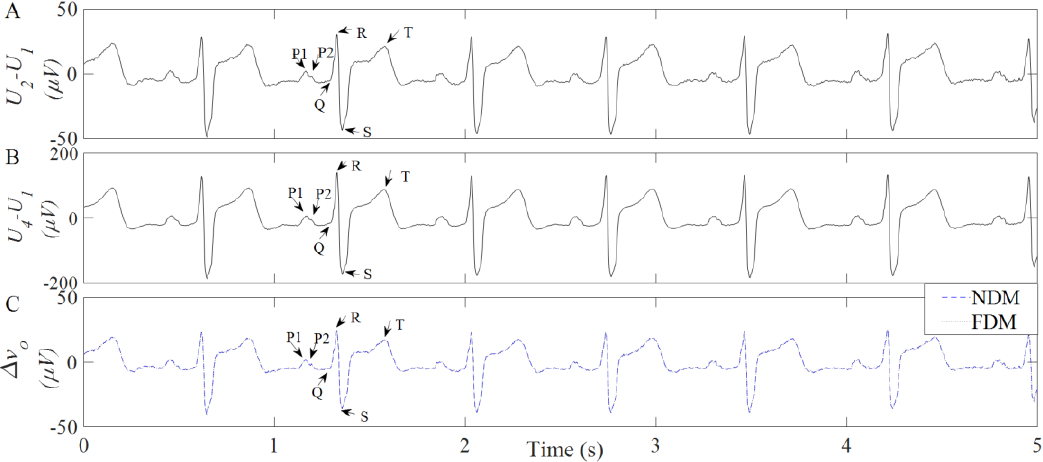
Figure 7. ECG signals: recorded bipolar signals U 2 - U 1 and U 4 - U 1 (panels ( A ) and ( B ) respectively) and Laplacian estimates based on NDM and FDM (panel ( C )).